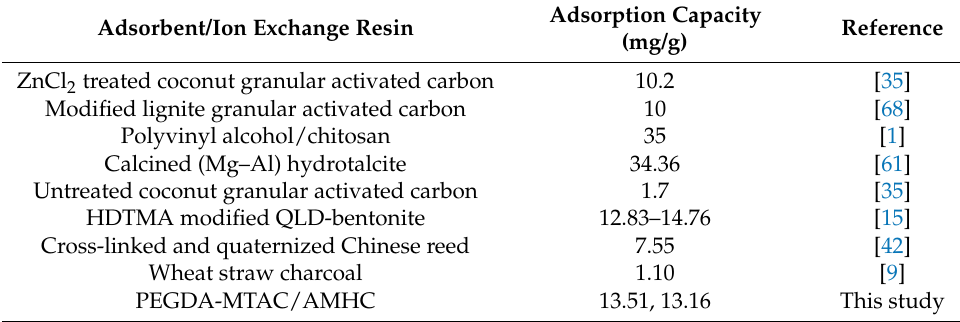
Table 7. Comparison of nitrate adsorption capacity on PEGDA-MTAC/AMHC with other re- ported